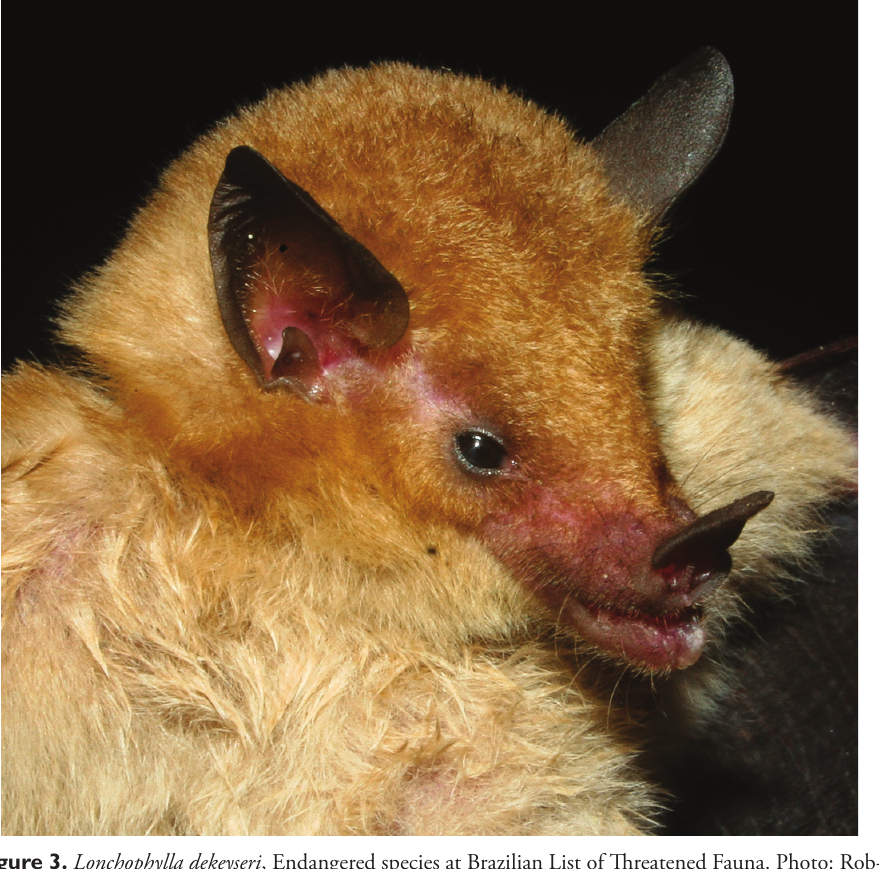
Figure 3. Lonchophylla dekeyseri , Endangered species at Brazilian List of Threatened Fauna. Photo: Rob- erto Leonam Morim